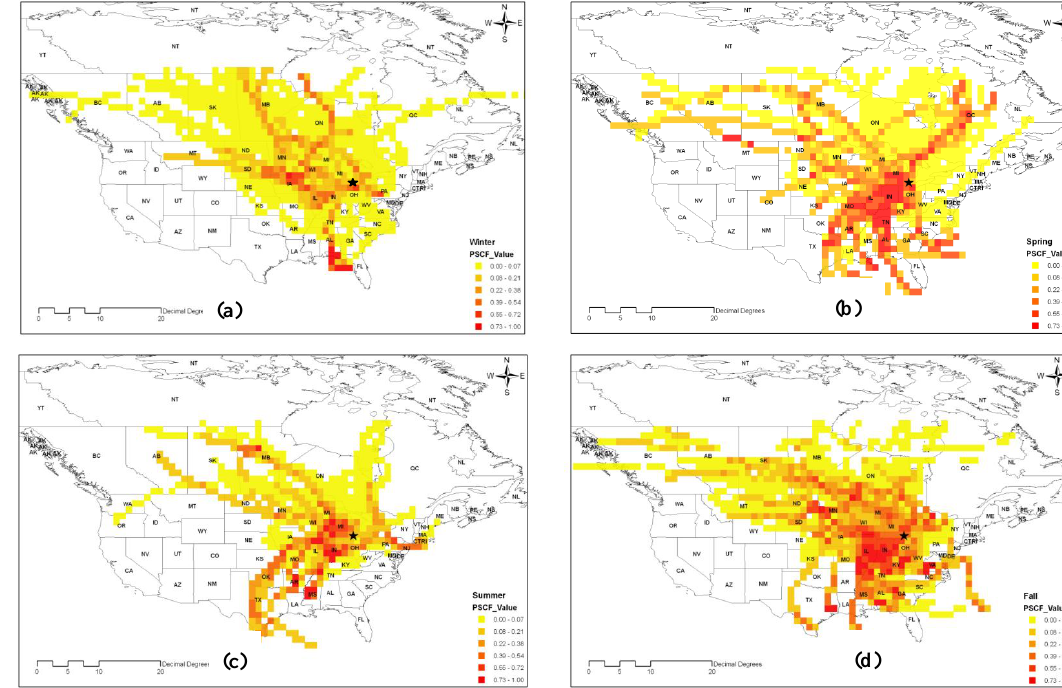
Fig. 6. Weighted PSCF for Windsor in (a) winter, (b) spring, (c) summer, and (d) fall, using seasonal means.